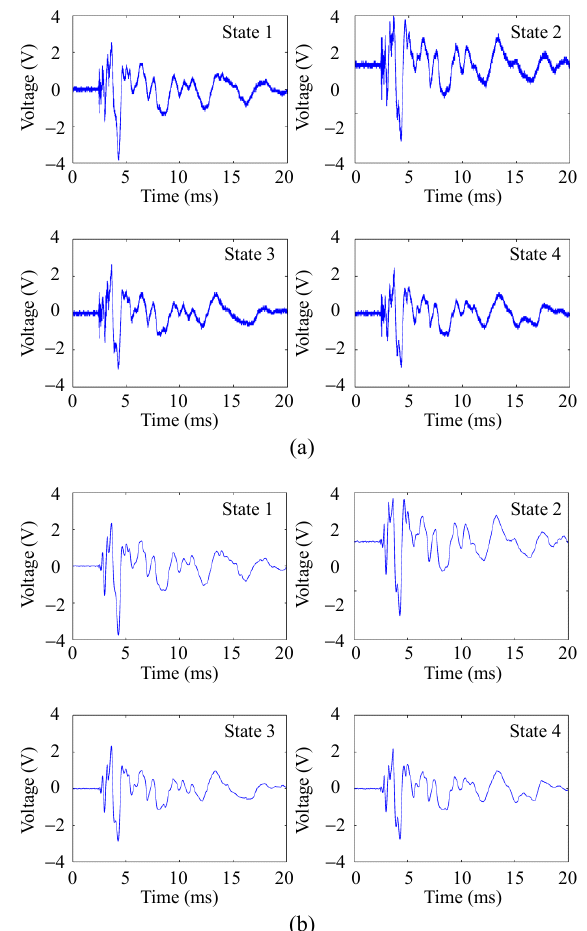
Fig. 6 Signals detected by FBG1 (a) before and (b) after wavelet transform denoising.